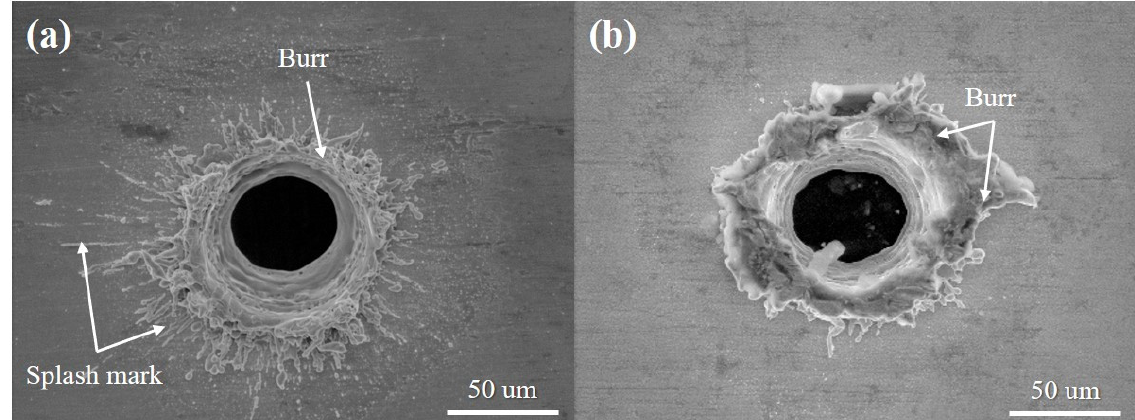
Figure 9 . SEM images of holes in ( a ) Au-coated and ( b ) non-coated specimens formed by laser spot cutting ( E Total = 200 mJ, Δ t = 200 ) .